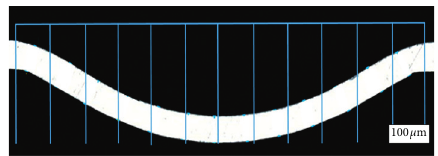
Figure 8: Selection of measurement